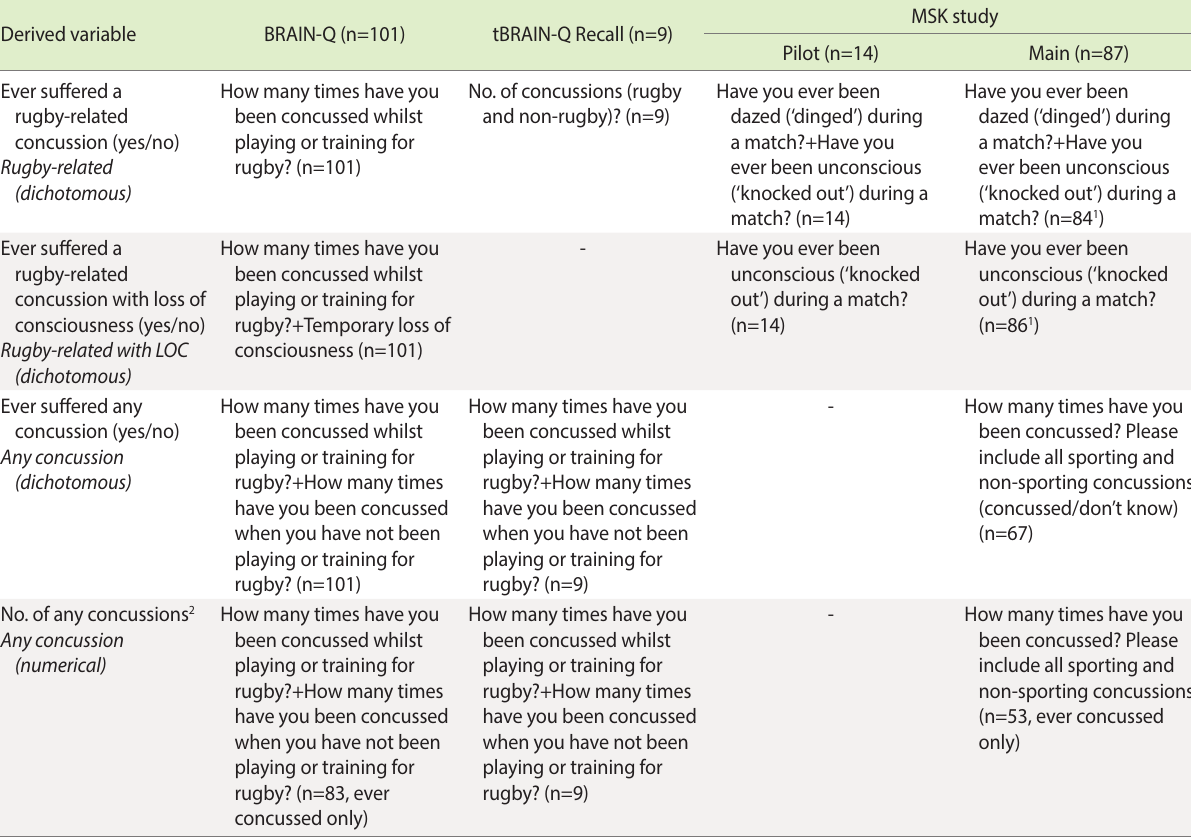
Table 1. The 4 concussion variables used in the analysis and how they were derived from each data source Derived